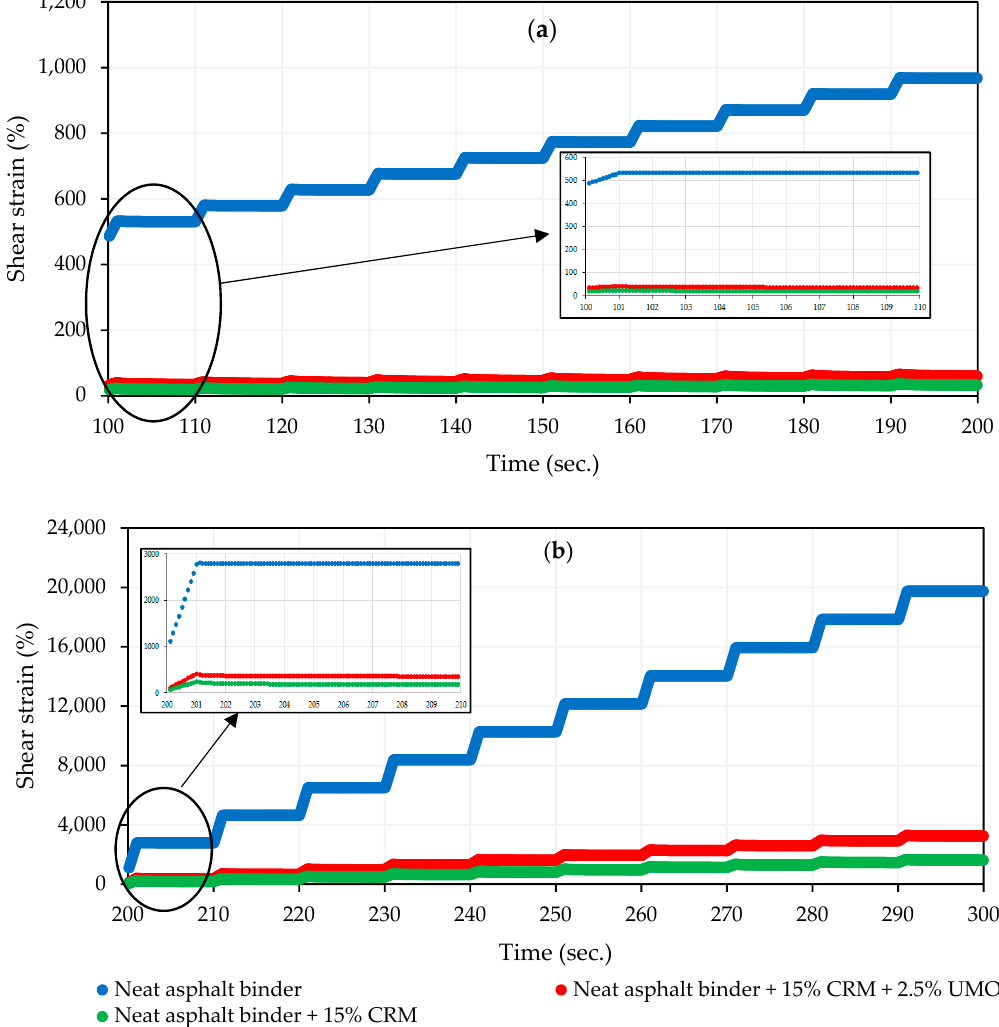
Figure 13. MSCR results for PG 52-28 neat and modified binders interacted at 170 ° C—50 Hz—75 min, tested at 60 °C: ( a ) 0.1 KPa; ( b ) 3.2 KPa shear stress.